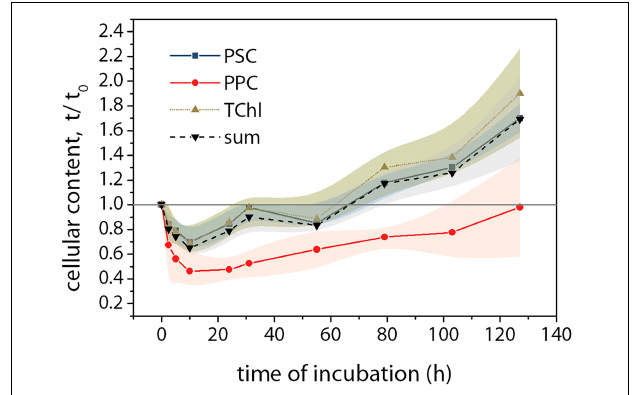
FIGURE 5 | Variations of pigment contents during the incubation compared to that at t 0 . Pigments were analyzed using Ultra-High Performance Liquid Chromatography (UHPLC, Suzuki et al., 2015). Squares, photosynthetic carotenoids (PSC = fucoxanthin); Circles, photoprotective carotenoids (PPC = diadinoxanthin + diatoxanthin + β -carotene); upward triangles, total chlorophyll (TChl = Chl c + Chl a ); downward triangles, the sum of all pigments. Mean values ( ± SD) are the average of four independent measurements.